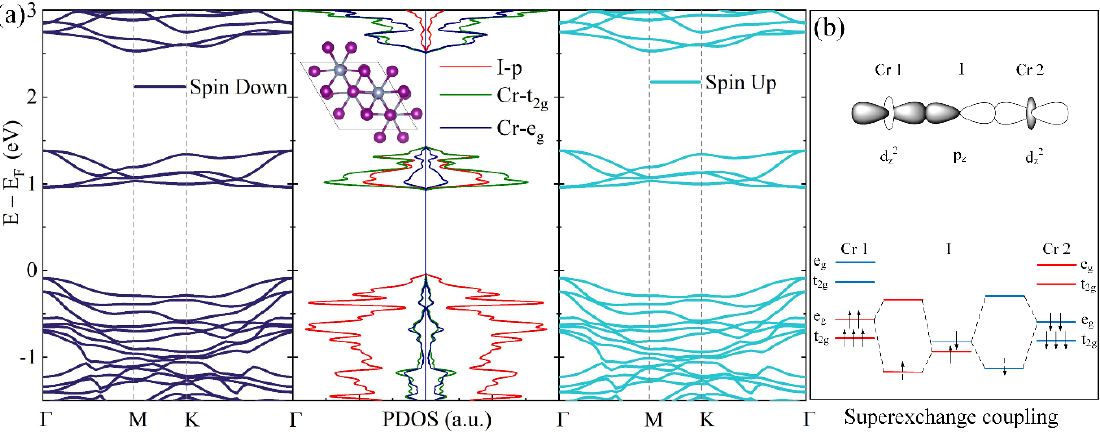
Figure 1. ( a ) Band structures and projected density of states (PDOS) of pristine high-temperature (HT)-phase of the CrI 3 bilayer, respectively. ( b ) Schematic diagram of the antiferromagnetic (AFM) superexchange coupling mechanism.